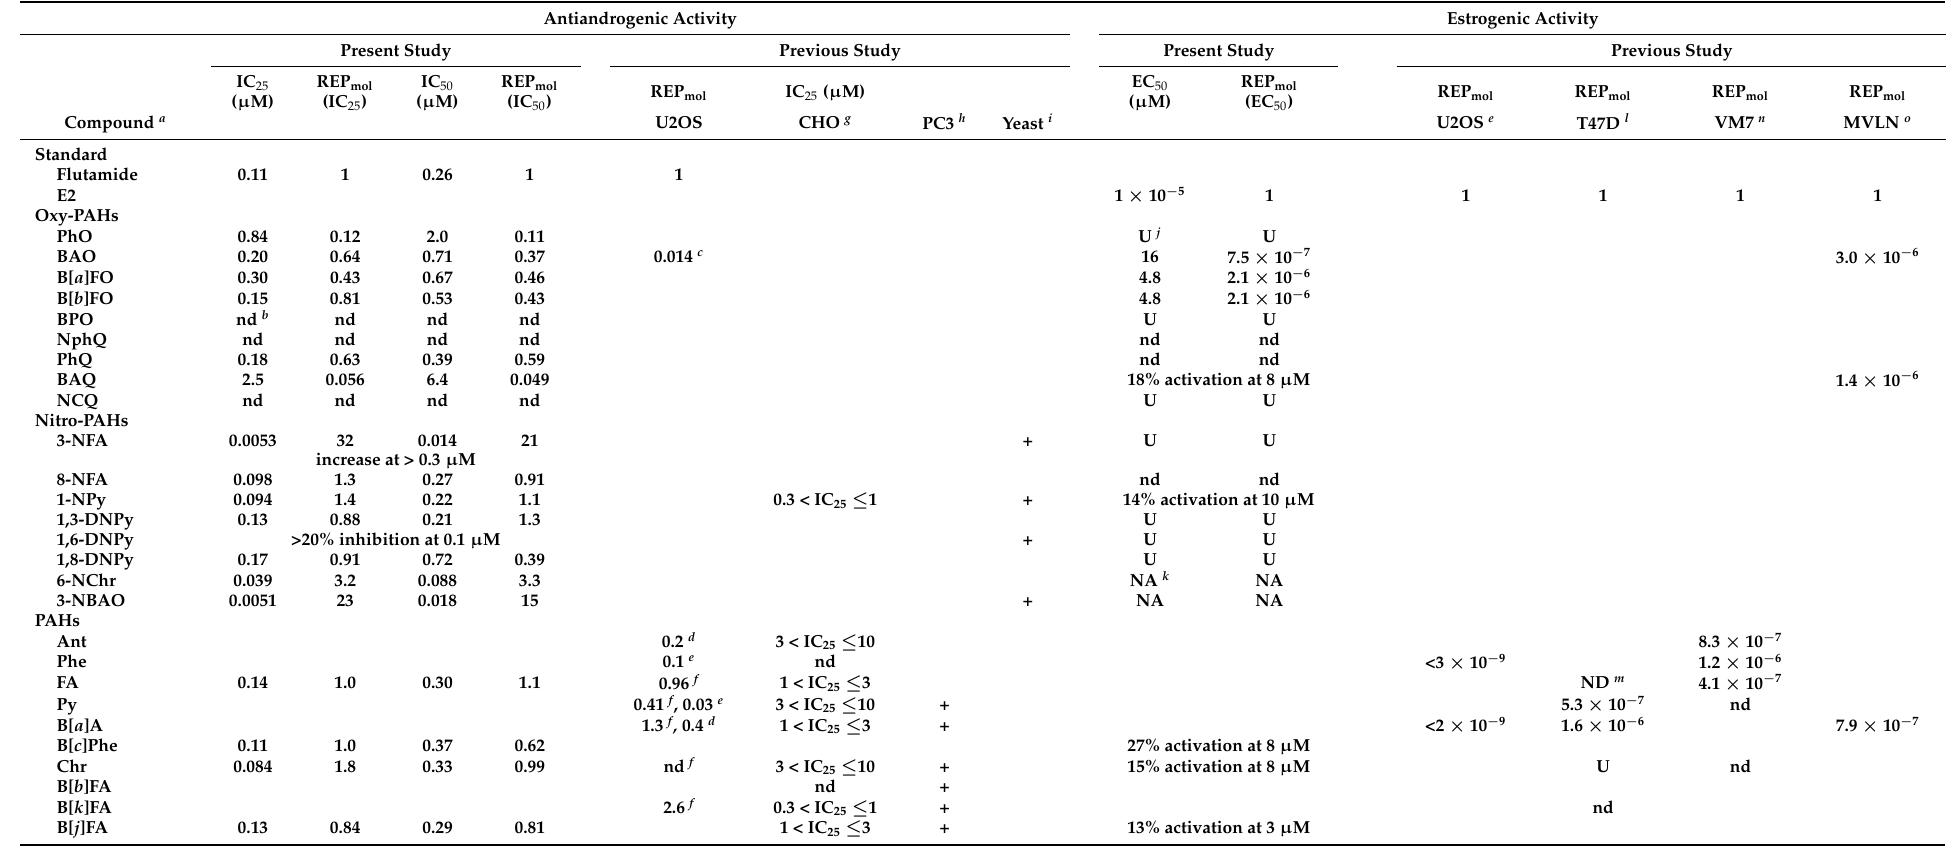
Table 1. Antiandrogenic and estrogenic activities and REP values for the studied oxy-PAHs, nitro-PAHs, and